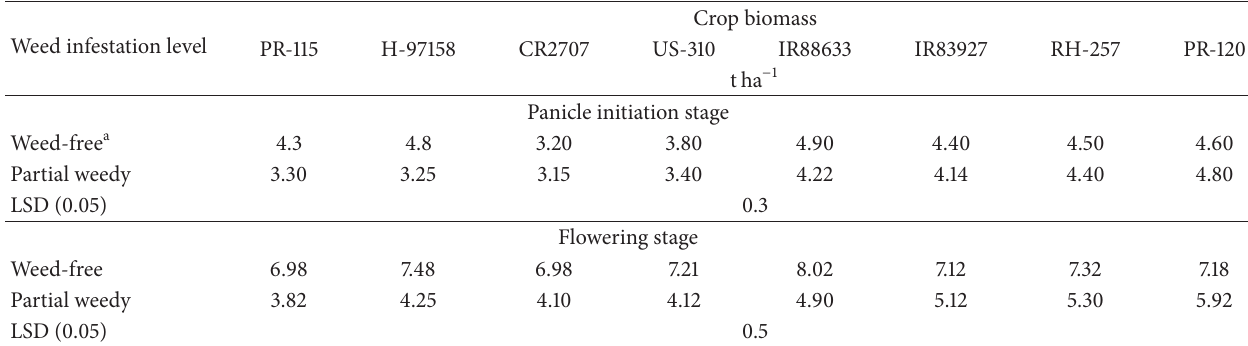
Table 8: Crop biomass (tha −1 ) in response to the interaction effect of weed infestation levels and genotypes at panicle initiation and flowering